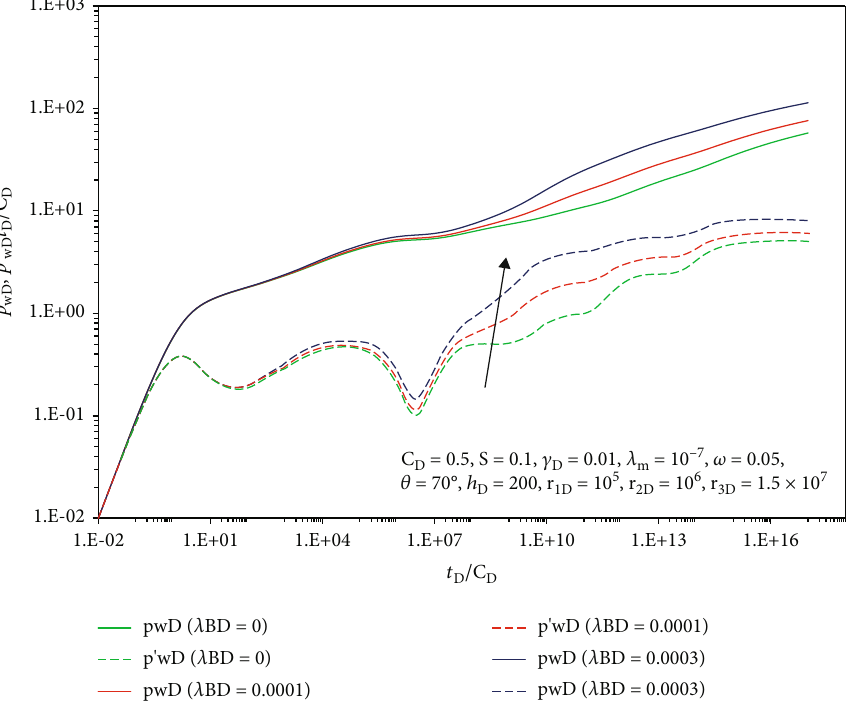
Figure 7: In fl uence of threshold pressure gradient on pressure dynamic